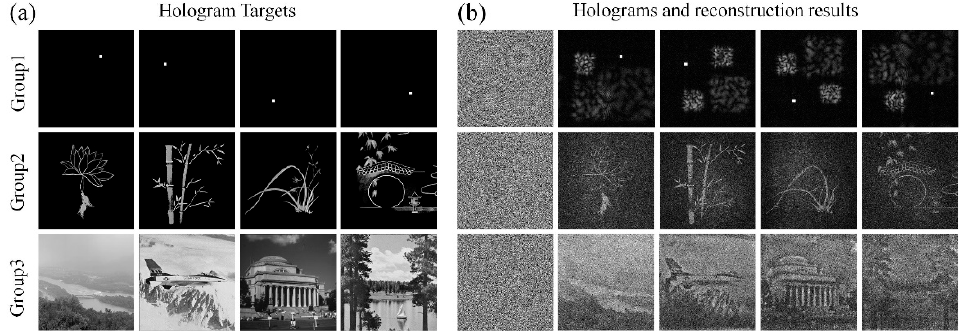
Figure 3. Three types of patterns. ( a ) represents the targets of the hologram. ( b ) represents the holograms and its reconstruction results.